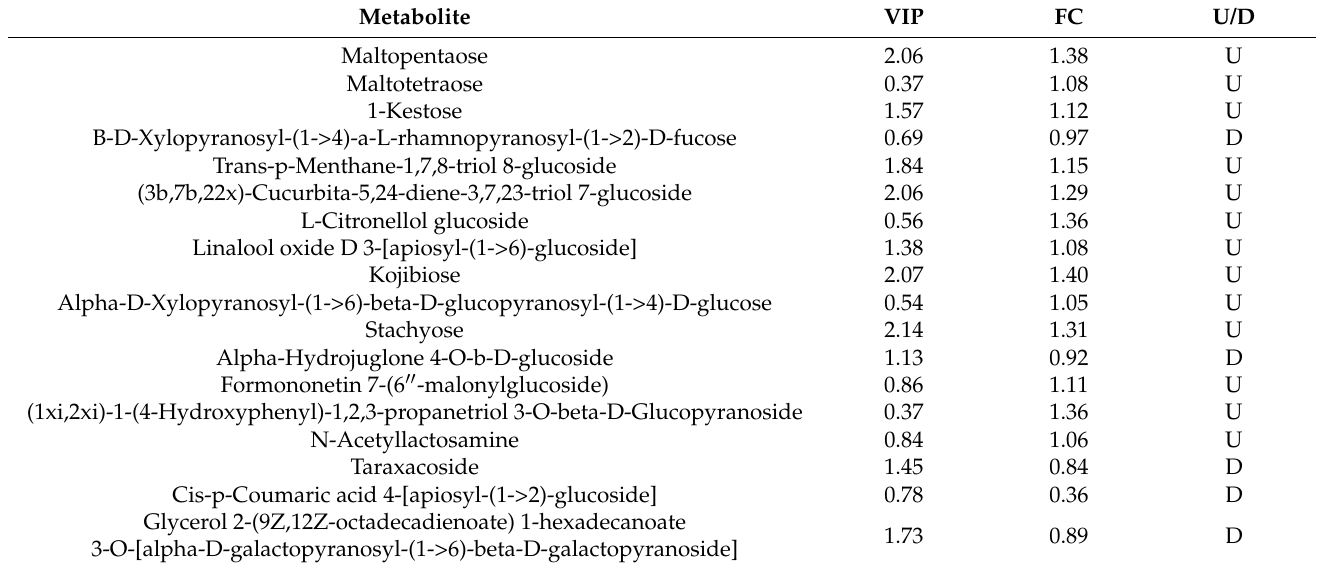
Table 3. Differential metabolites of polysaccharides and related compounds.